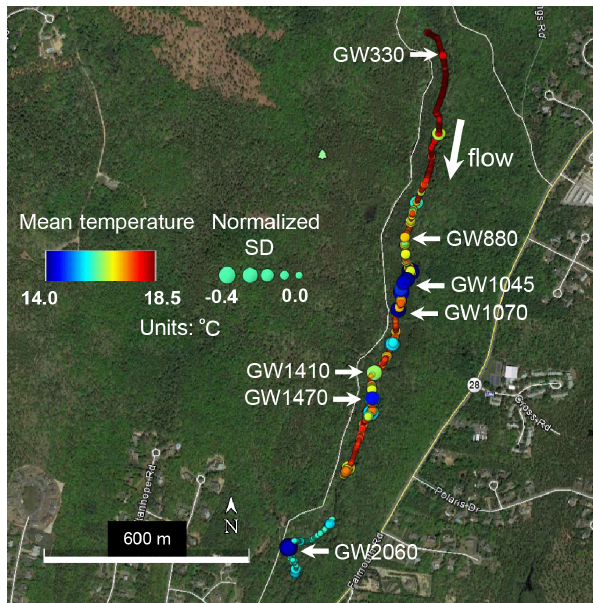
Figure 1. Fiber-optic distributed temperature data collected along the stream channel sediment–water interface over two days in July 2013 are summarized here using mean temperature (color) and tem- perature standard deviation normalized to known non-seepage loca- tions (size). Locations of reduced mean temperature and the stan- dard deviation of temperature can indicate zones of preferential groundwater upwelling. A subset of these apparent upwelling zones (labeled “GW” followed by the distance from upper reach bound- ary in meters) with varied thermal statistics was chosen for direct pore-water sampling and quantitative seepage measurements. This figure was modified from Rosenberry et al.